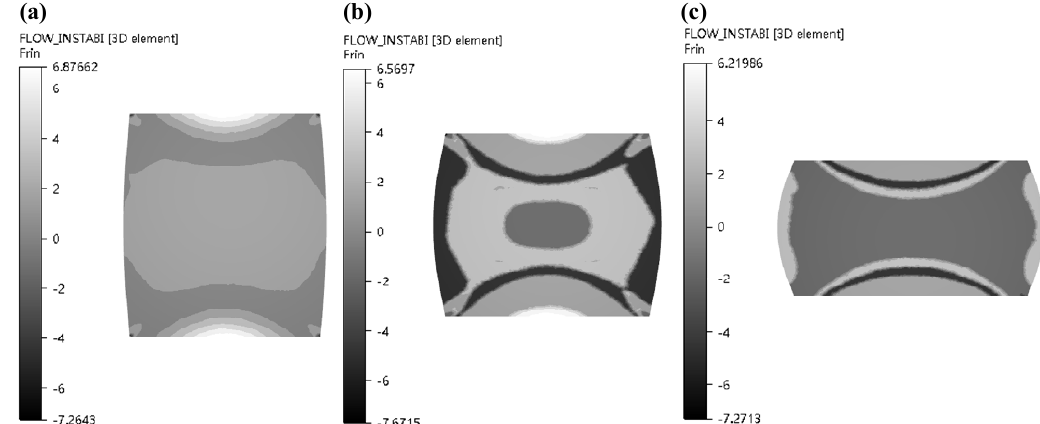
Figure 15. Distributions of ξ (instability coe ffi cient) in the condition of 1050 ◦ C / 0.1 s − 1 under various strains: ( a ) ε = 0.2; ( b ) ε = 0.4; ( c ) ε = 0.7.